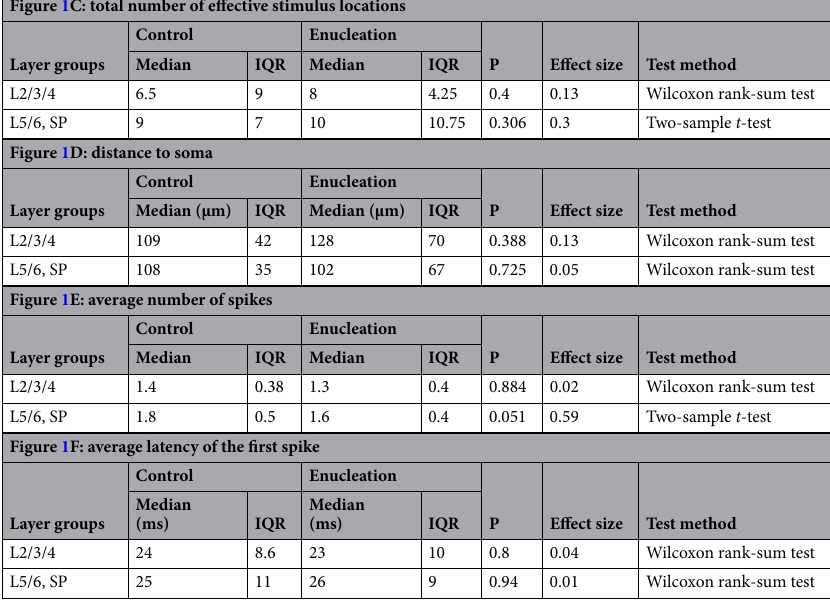
Figure 1C: total number of effective stimulus locations